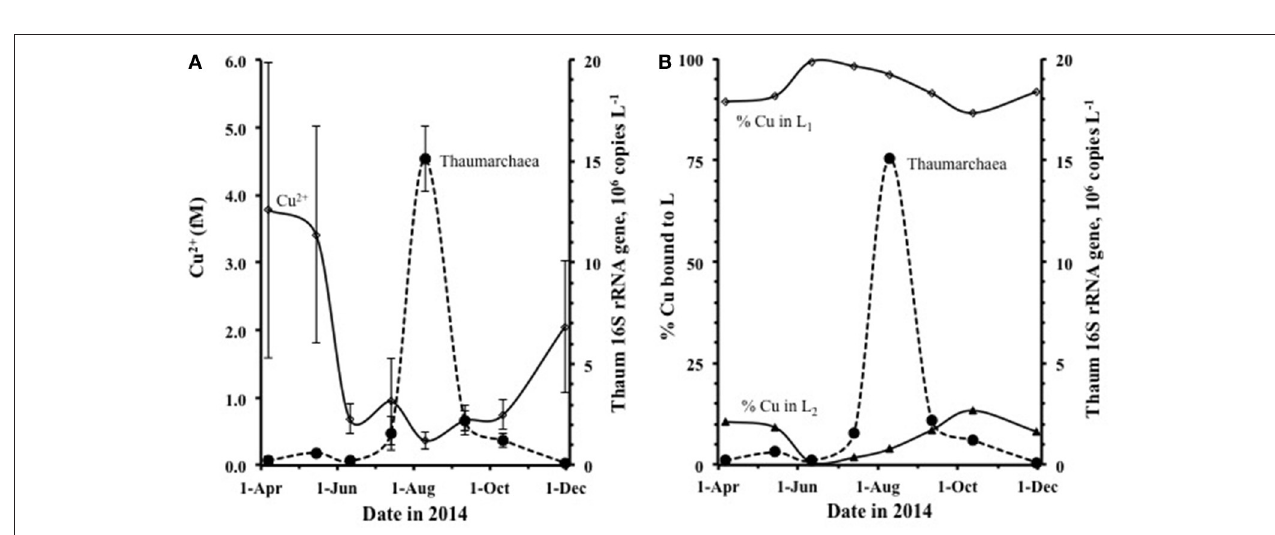
FIGURE 5 | The variation in Thaumarchaea abundance each month sampled compared to (A) the concentration of Cu 2 + , shown in femtomolar and (B) the % distribution of copper bound to L 1 and L 2 . Each data point shown is the average of 6 separate sample-stations, and the standard deviations are